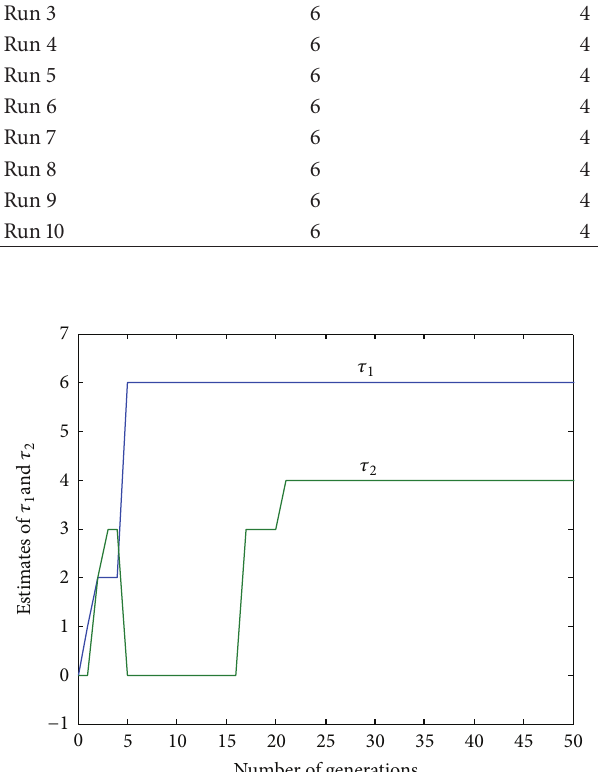
Figure 1: Estimates of 𝜏 1 and 𝜏 2 for Run 1 of Example